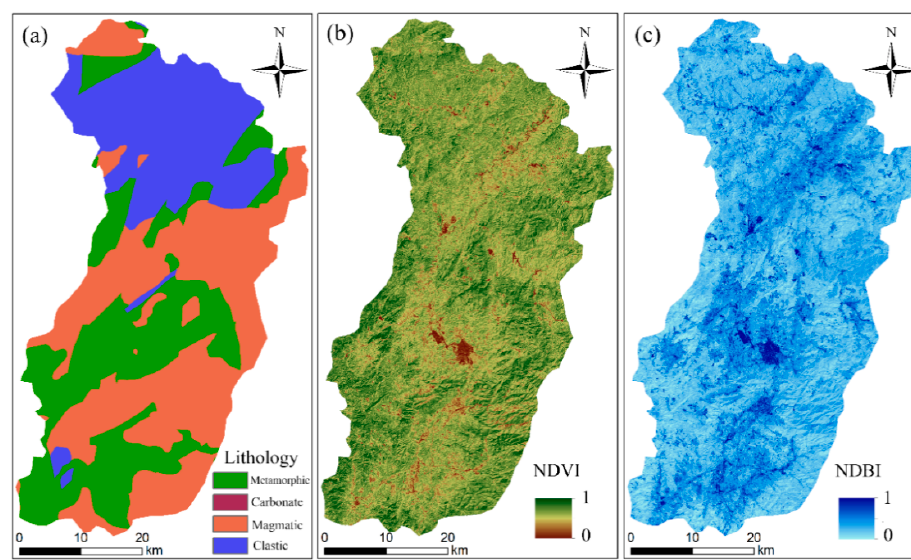
Figure 6. Land cover, hydrology and geological factors: ( a ) Lithology, ( b ) normalized differential vegetation index (NDVI) and ( c ) normalized difference built-up index (NDBI). (4) Relationships between collapse and lithology.